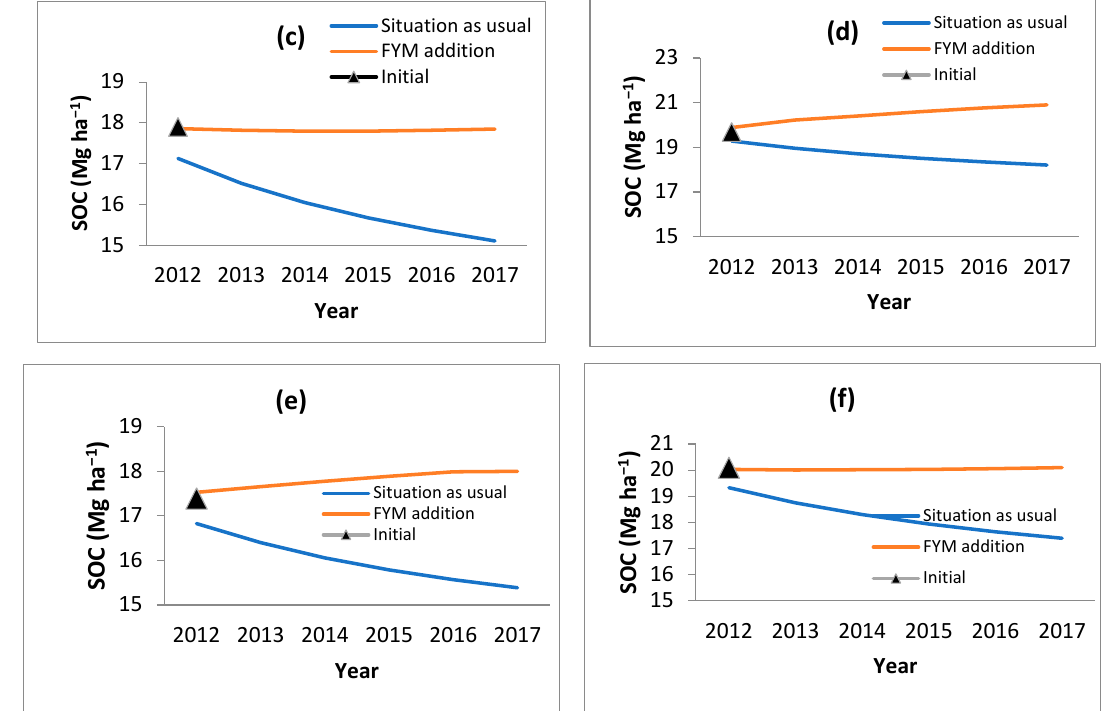
Figure 5. Change in SOC with addition of FYM @ 9 t ha − 1 in ( a ) B. balcooa , ( b ) B. bambos , ( c ) B. nutans , ( d ) D. hamiltonii , ( e ) D. stocksii and ( f ) D. strictus.